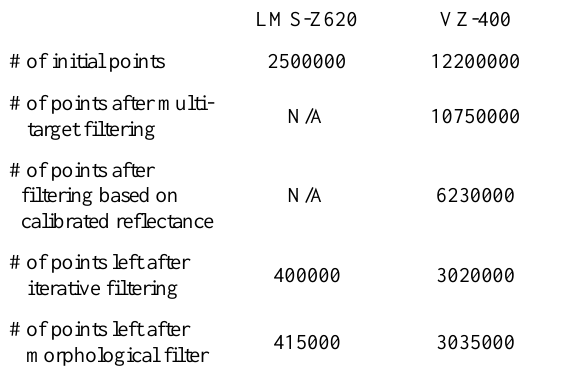
Table 4: Results of the filtering of the Riegl LMS-Z260 and Riegl VZ-400